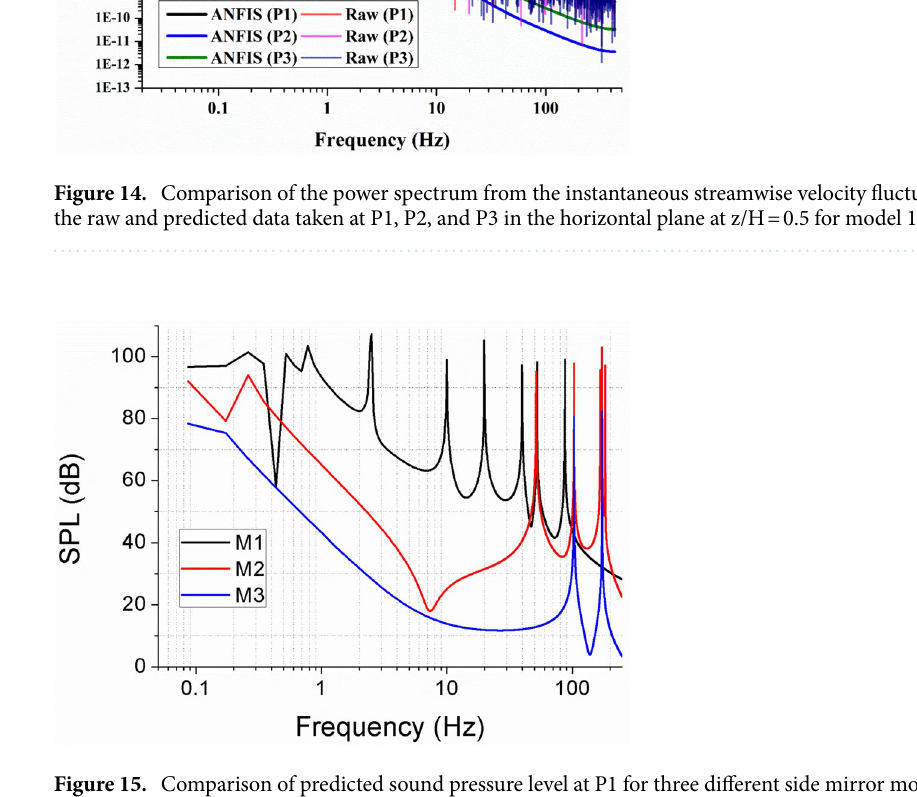
Figure 15. Comparison of predicted sound pressure level at P1 for three different side mirror